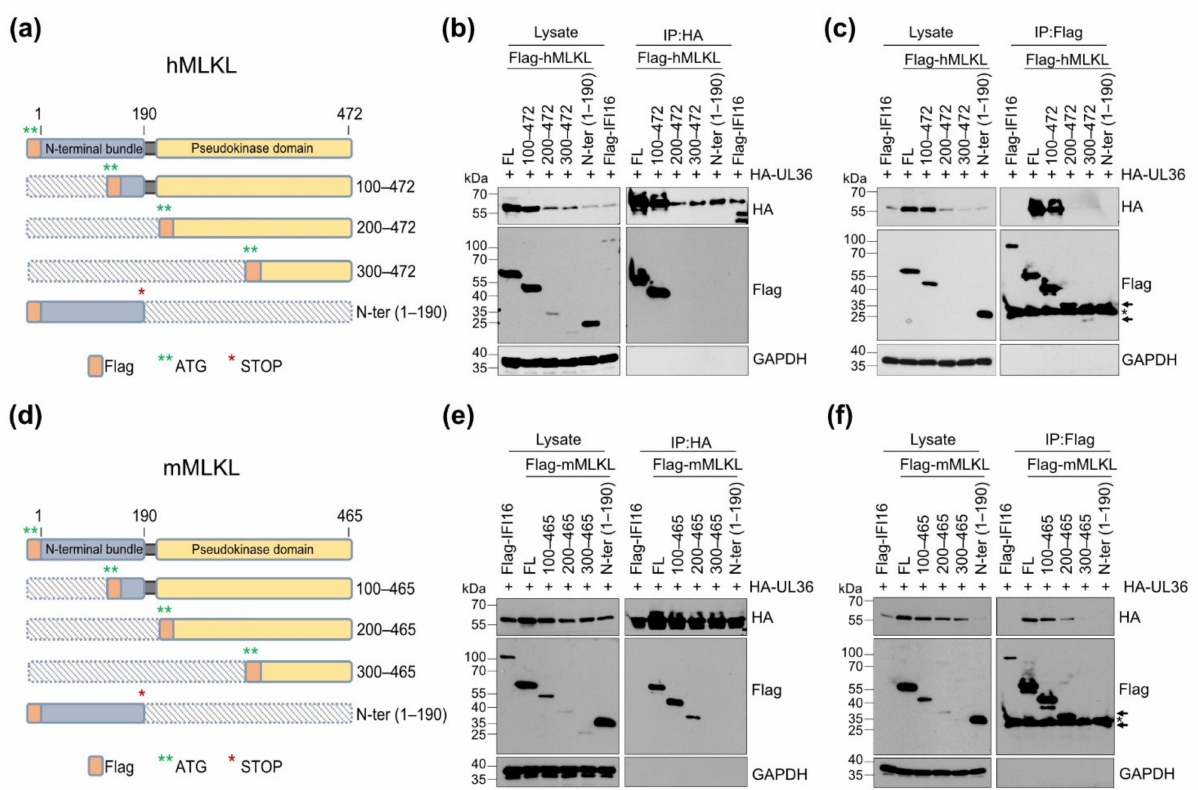
Figure 3. HCMV UL36 interacts with the N-terminal domain of MLKL. ( a ) Schematic depiction of hMLKL, consisting of an N-terminal four-helix bundle and a C-terminal pseudokinase domain, and truncation mutants. Hatched regions were deleted. ( b ) HEK-293A cells were co-transfected with plasmids expressing HA-tagged UL36 and Flag-tagged hMLKL truncation mutants. HA-UL36 was immunoprecipitated, and co-precipitating Flag-MLKLs were detected by Western blot. Flag-tagged IFI16 served as a negative control. ( c ) HEK-293A cells were transfected with plasmids as in ( b ). Flag- MLKLs were immunoprecipitated, and co-precipitating HA-UL36 was detected by Western blot. ( d ) Schematic depiction of mMLKL truncation mutants. ( e ) HEK-293A cells were co-transfected with plasmids expressing HA-UL36 and Flag-mMLKL truncation mutants. HA-UL36 was immunoprecipitated, and co-precipitating Flag-MLKLs were detected by Western blot. Flag-IFI16 served as a negative control. ( f ) HEK-293A cells were transfected with plasmids as in ( e ). Flag-MLKLs were immunoprecipitated, and co-precipitating HA-UL36 was detected by Western blot. + indicates transfection with pcDNA